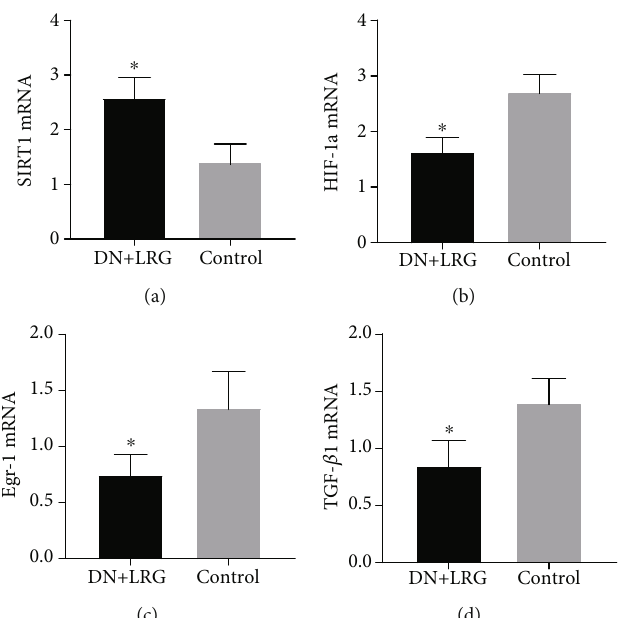
Figure 13: Expression of SIRT1, HIF-1a, Egr-1, and TGF- β 1 mRNAs in the liver. Control: diabetic nephropathy group; DN+LRG: diabetic nephropathy+liraglutide group; Egr-1: early growth response-1; HIF-1a: hypoxia-inducible factor-1 alpha; TGF- β 1: transforming growth factor- β 1. ∗ P < 0 : 05 vs. the control.